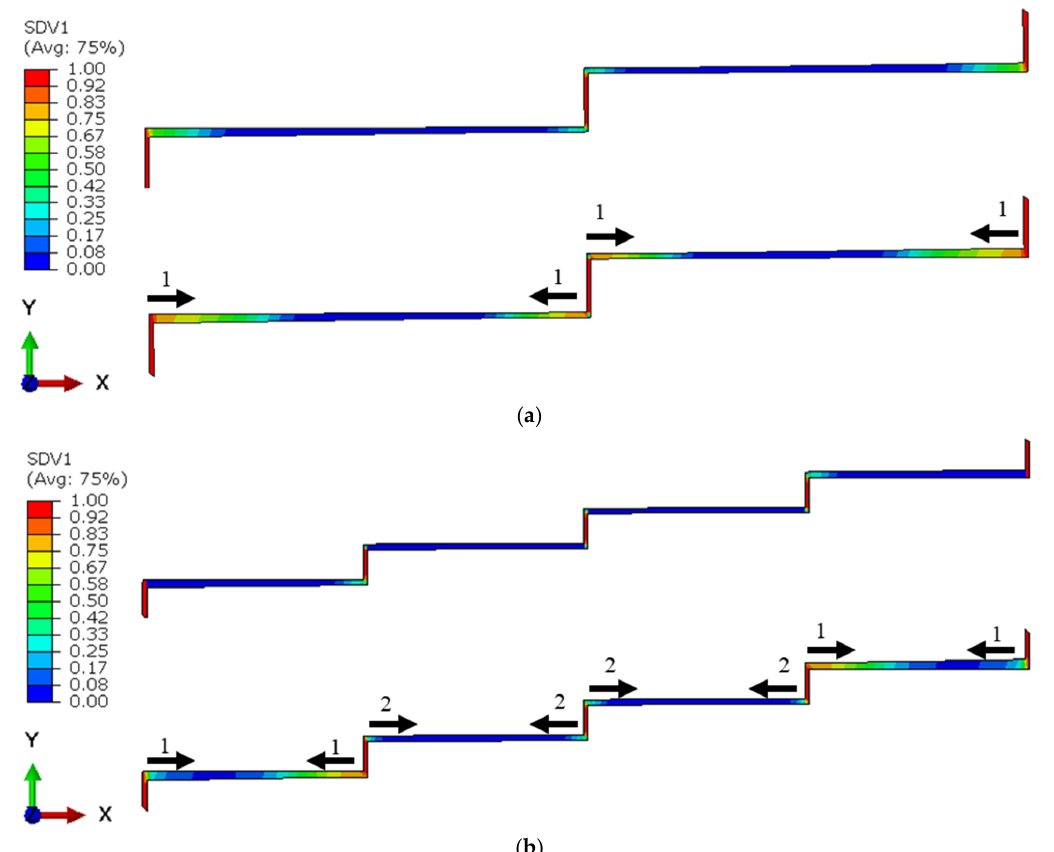
Figure 6. Distribution of the fatigue damage in the adhesive layer with the crack propagation direc ‐ tion and its sequence for the two ‐ ( a ) and four ‐ step ‐ lap joints ( b ) subjected to 8 kN tensile loading at N f /3 ( top ) and 2 N f /3 ( bottom ). Numbers 1 and 2 in the figure represent the sequence of the crack propagation.